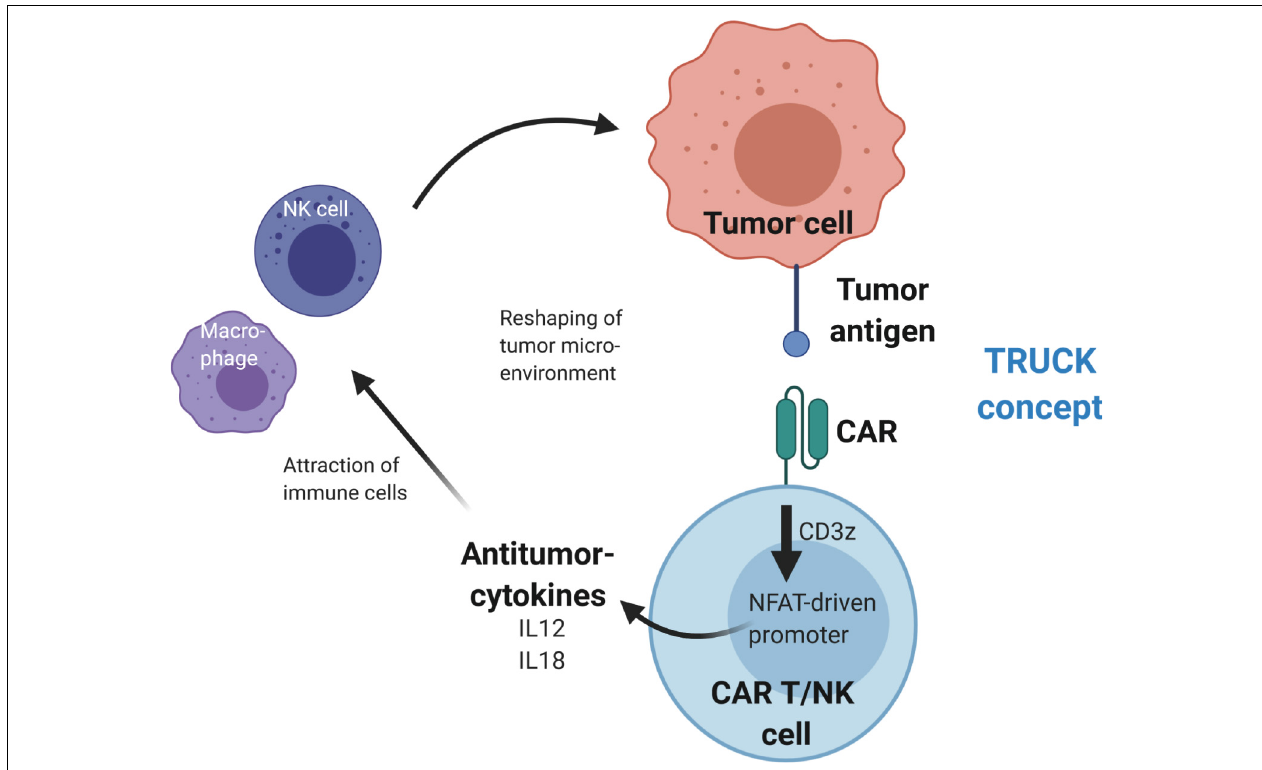
FIGURE 3 | Reshaping of the tumor microenvironment using T cells redirected for universal cytokine killing (TRUCK). Upon antigen binding, the CAR activates CD3z(eta) signaling, which leads to activation of an NFAT-driven promoter that controls expression of antitumor-cytokine cassette, e.g., IL12 or IL18. The cytokines are then secreted from the CAR T or CAR NK cells into the tumor microenvironment, where they recruit additional immune cells to enhance the antitumor